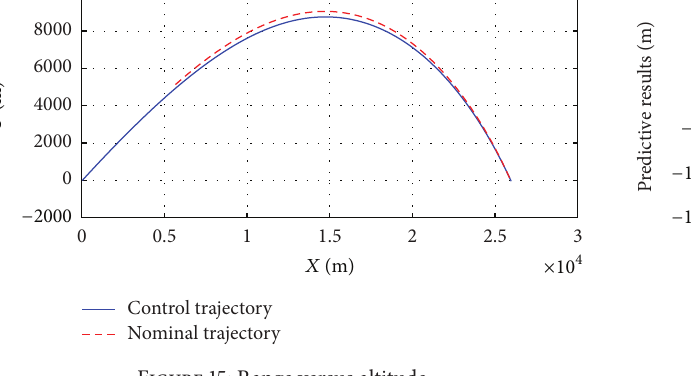
Figure 17: Predictive results.